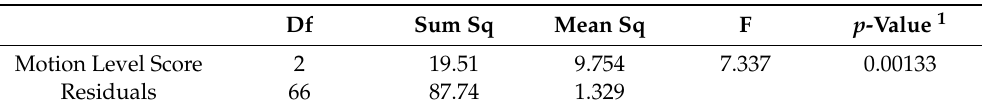
Table 3. Summary of the results of the one-way ANOVA test conducted on the mean scores assigned to three levels of motion in Figure 10.